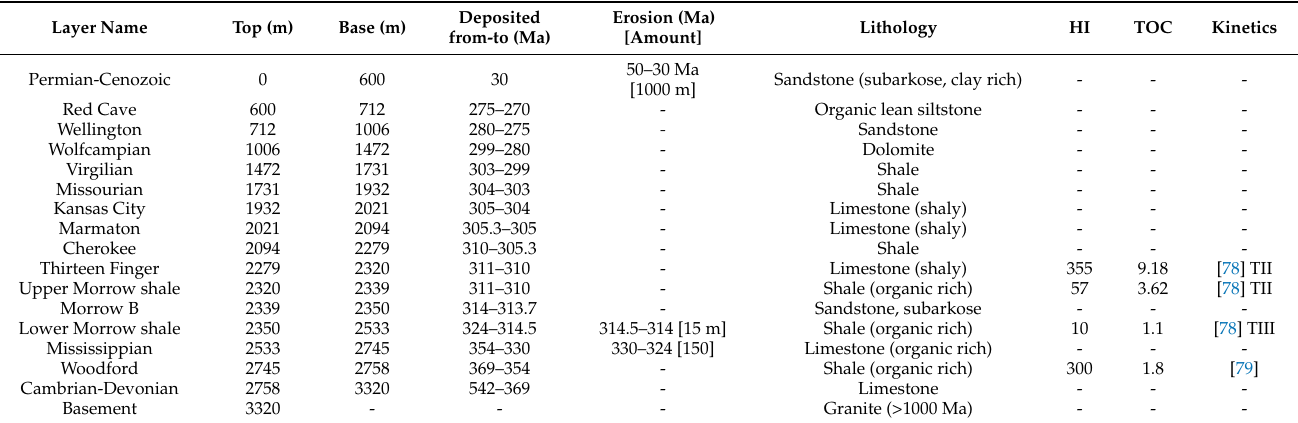
Table 2. 1D Petroleum system model input, well 13-10A. HI is Hydrogen Index, TOC is Total Organic